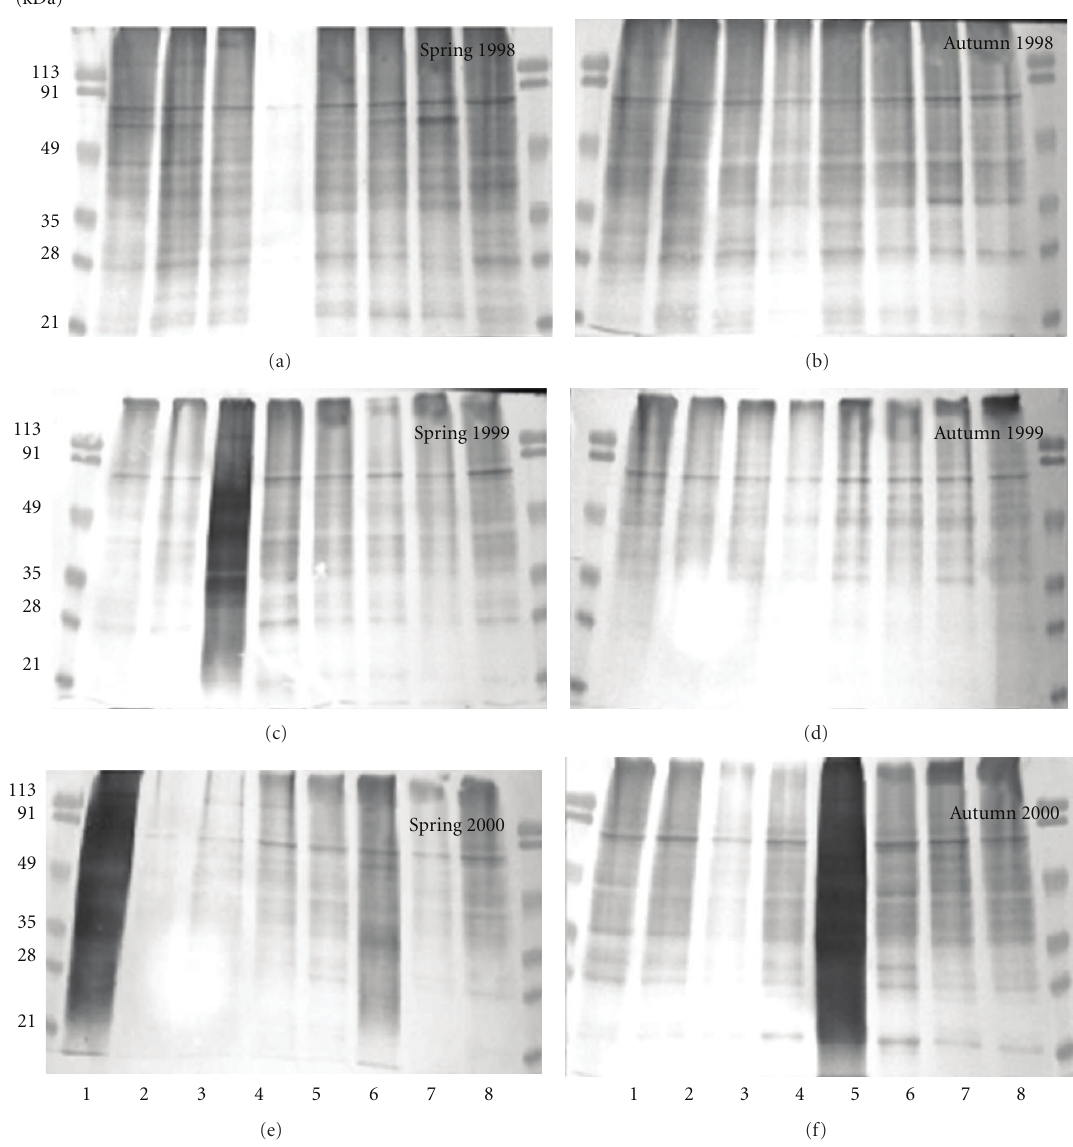
Figure 10: Oxidized protein profiles, text otherwise as in Figure